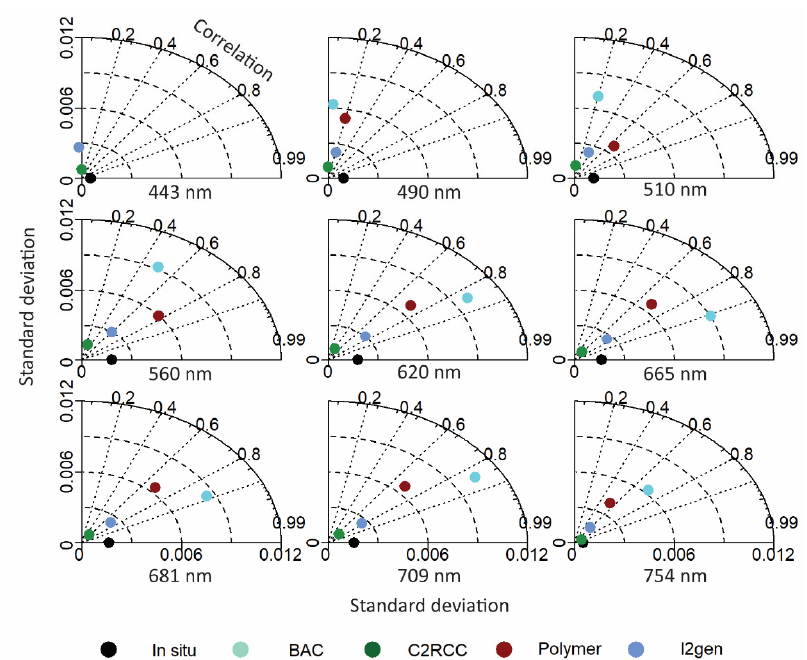
Figure 6. Taylor diagrams of atmospherically corrected R rs in comparison to in situ R rs . Each panel shows separately the results for nine OLCI wavelengths ranging from 443 to 754 nm. Standard deviation is illustrated as the radial distance from the origin, correlation coefficients are shown on the arc of the coordinate plot with points closest to the x ‐ axis containing the highest correlation, and RMSE is indicated by the concentric dashed lines emanating from the origin where points farthest from the observed value have high RMSE error. The spatial variability of pixel flagging for each atmospheric correction processor demonstrates that more pixels are flagged (reduction in clear day pixels) in the Upper Bay and along the coastline (Figure 7). Across all 2020 OLCI scenes of only Chesapeake Bay water pixels, IdePix flagged 46% of pixels as clouds and 59% as associated cloud pixels (i.e., cloud margin, cloud shadow, etc.), 39% as bright pixels, and 4% as land although land was previously masked out. The BAC quality flags (WQSF_lsb) flagged 57% of water pixels as cloud ‐ associated flags, 8% as high glint, and 3% as invalid or ‘AC fail’. The BAC science flags (WQSF_msb) flagged 2–11% of water pixels as negative water ‐ leaving radi ‐ ance for wavebands 412–665 nm, with more flagging at the lower wavelengths. POLY ‐ MER quality flags flagged 49% of water pixels as clouds, 4% as invalid and 1% as thick aerosol. L2gen flags flagged 61% as clouds, 9% as atmospheric correction warning, 6% as high glint, and 14% as land although the land was previously masked out. The default land mask for L2gen is approximately 500 m which leads to masking out water pixels in narrow tributaries and could be rectified by passing a null landmask or defining a custom mask (Sean Bailey, personal communication). Clear day coverage is lowest for the L2gen processing workflow and highest for the POLYMER processing workflow (Figure 7). BAC flagging produced a mean of 52 clear days with higher coverage in the Middle and Lower Bay and less in the Upper Bay (Figure 7). C2RCC flagging produced an average of 58 clear days and is distributed across the entire bay. POLYMER flagging produced an average of 85 clear days which, like BAC, has higher coverage in the Middle and Lower Bay. L2gen flagging produced an average of 47